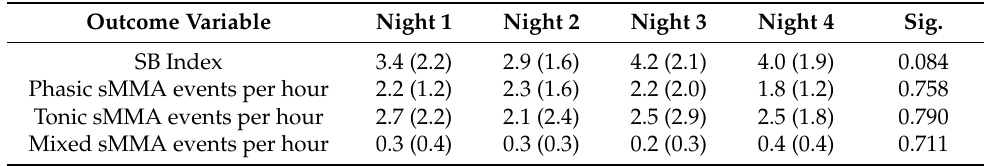
Table 3. Average values of outcome variables (s.d. in parenthesis) over each recording night and the ANOVA test for significant differences. (statistical significance: p <